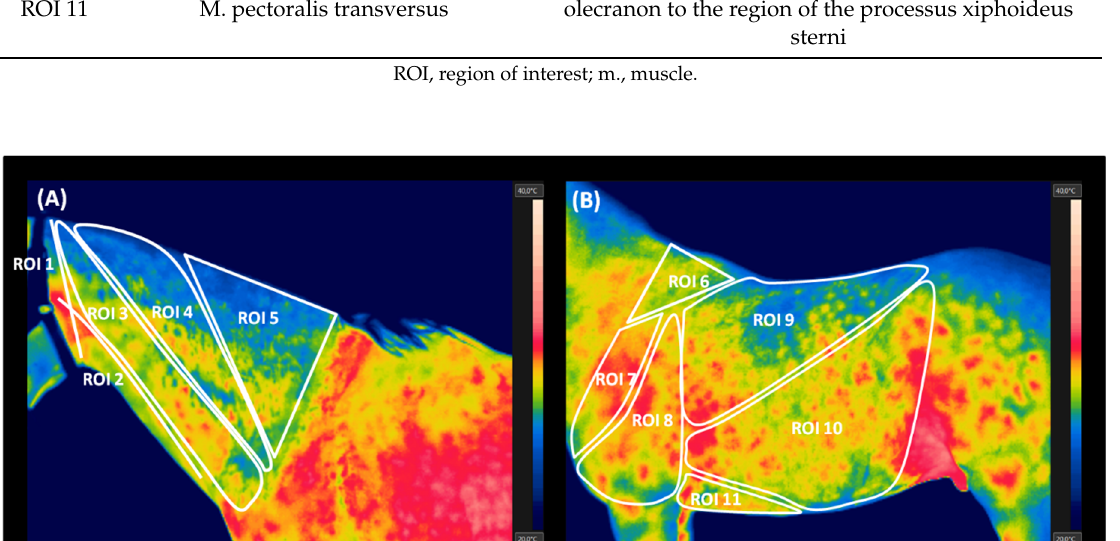
10; T Min 1 in ROIs 1, 3, 4, 7, 8, 10; T Aver 1 in ROI 5; T Max 2 in ROI 4; T Min 2 in ROIs 1–5 and 11; T Aver 2 in ROIs 1 and 3. Other data series showed normal distribution. Temperature data series were compared as paired data to estimate the differences between measurements (0, 1, 2) and between ROIs within each measurement using a repeated measures ANOVA summary with Tukey’s multiple comparisons test or Friedman test with Dunn’s multiple comparisons test, respectively. Repeated measures ANOVA summary with Tukey’s multiple comparisons test was used to compare